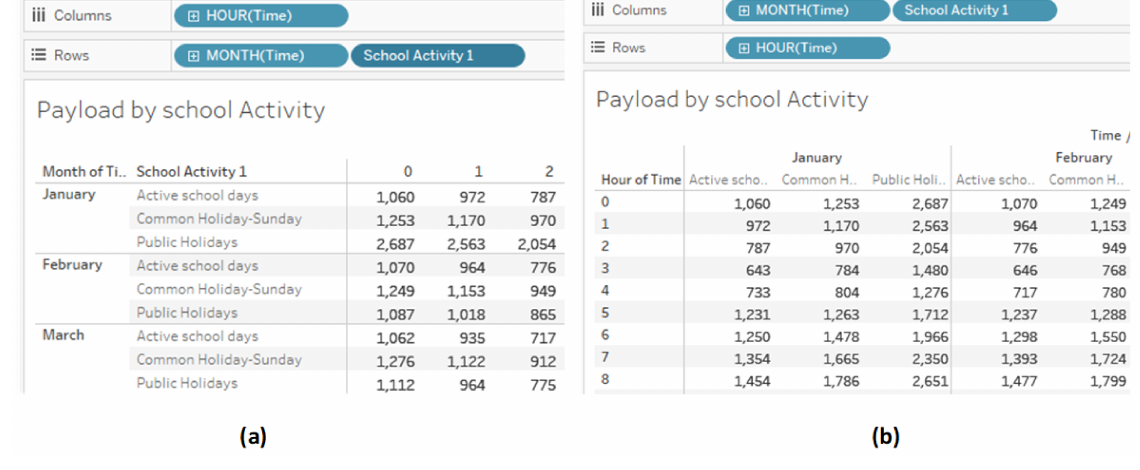
Fig. 7 Pivot ((a to b) or (b to